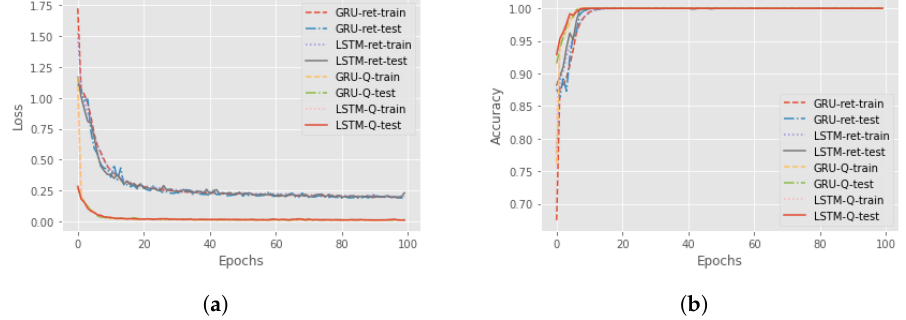
Figure 4. Comparison of losses and accuracy of RNNs with different cells and features for the Taxi problem. ( a ) Loss obtained during the training and test phase with different parameters. ( b ) Accuracy obtained during the training and test phase with different parameters.